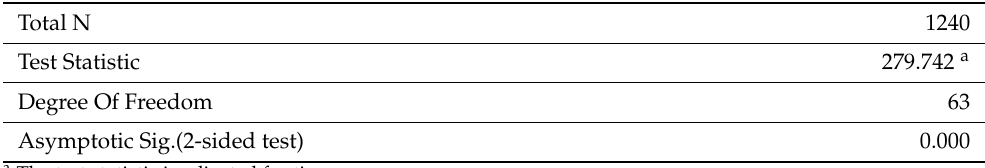
Table 8. Independent-Samples Kruskal–Wallis H Test Summary. The table shows the independent- samples Kruskal–Wallis H test between cell type groups’ viability scores. p -values under 0.05 indicate significant